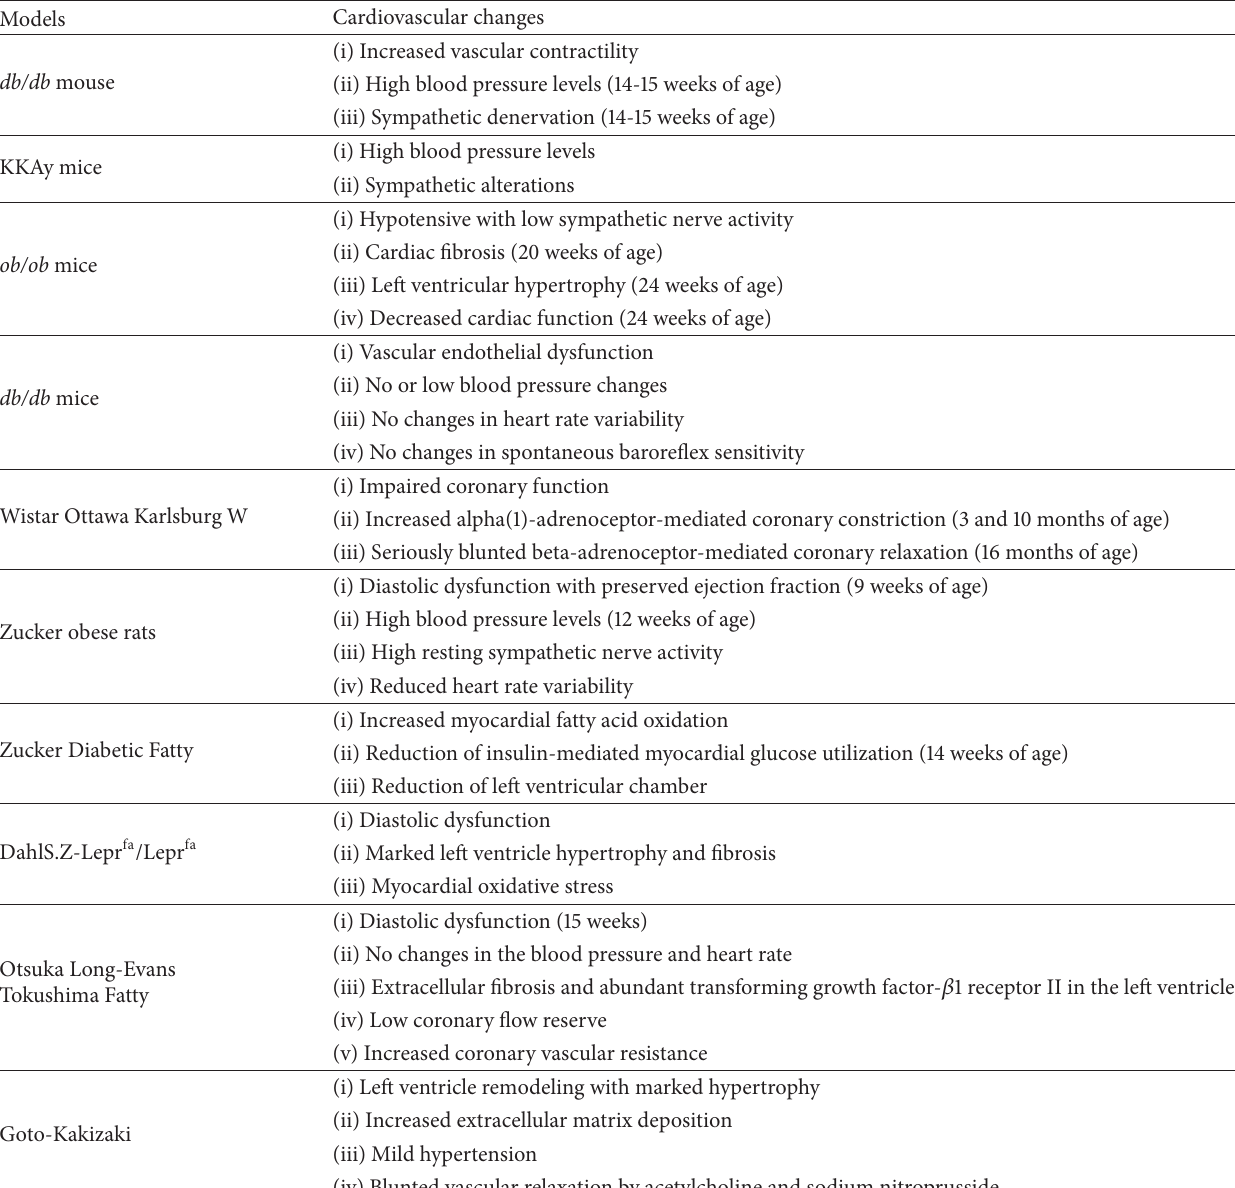
Table 1: Main cardiovascular findings in genetic models of metabolic